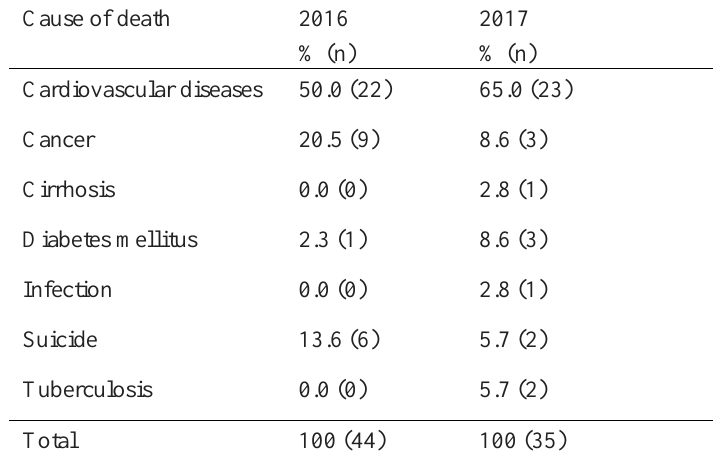
Table 4. January 2016 to September 2017 mortality rates by clinical indication for the Ksenyevka population typical for atherosclerosis were detected in 17.5% (n=22) of cases, while in 5.5% (n=7) of patients hadsignificant forms of severe peripheral